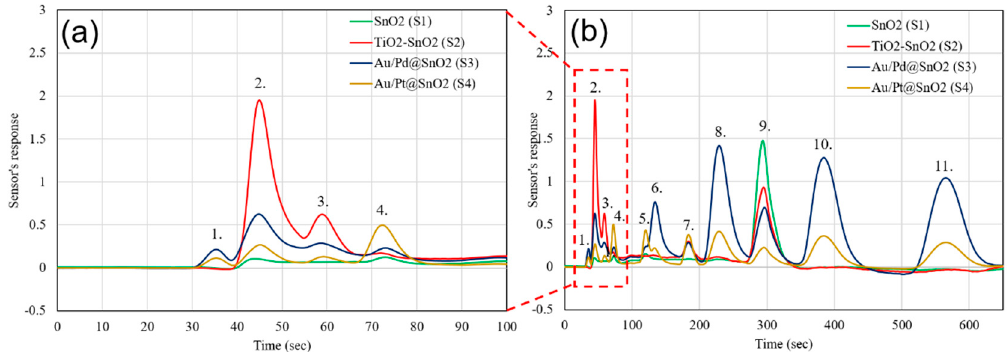
Figure 7. Gas chromatogram of Mix. 3: ( a ) Zoomed image of light compounds and ( b ) the full gas chromatogram. (1. CO 10 ppm, 2. H 2 S 100 ppb, 3. Ethyl-Mercaptan 50 ppb, 4. Acetone 50 ppb, 5. Ethanol 50 ppb, 6. Benzene 10 ppb, 7. Unknown, 8. Toluene 10 ppb, 9. Water, 10. Ethylbenzene 10 ppb, 11. O-Xylene 10 ppb).